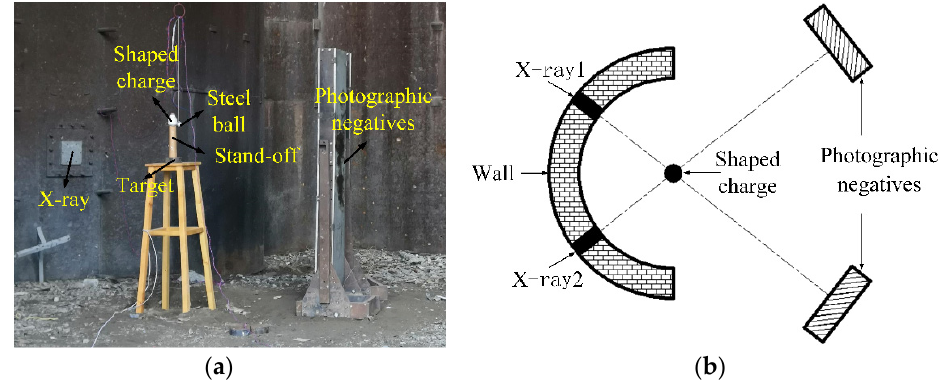
Figure 1. ( a ) Composition of experiment ( b ) schematic diagram of experiment.